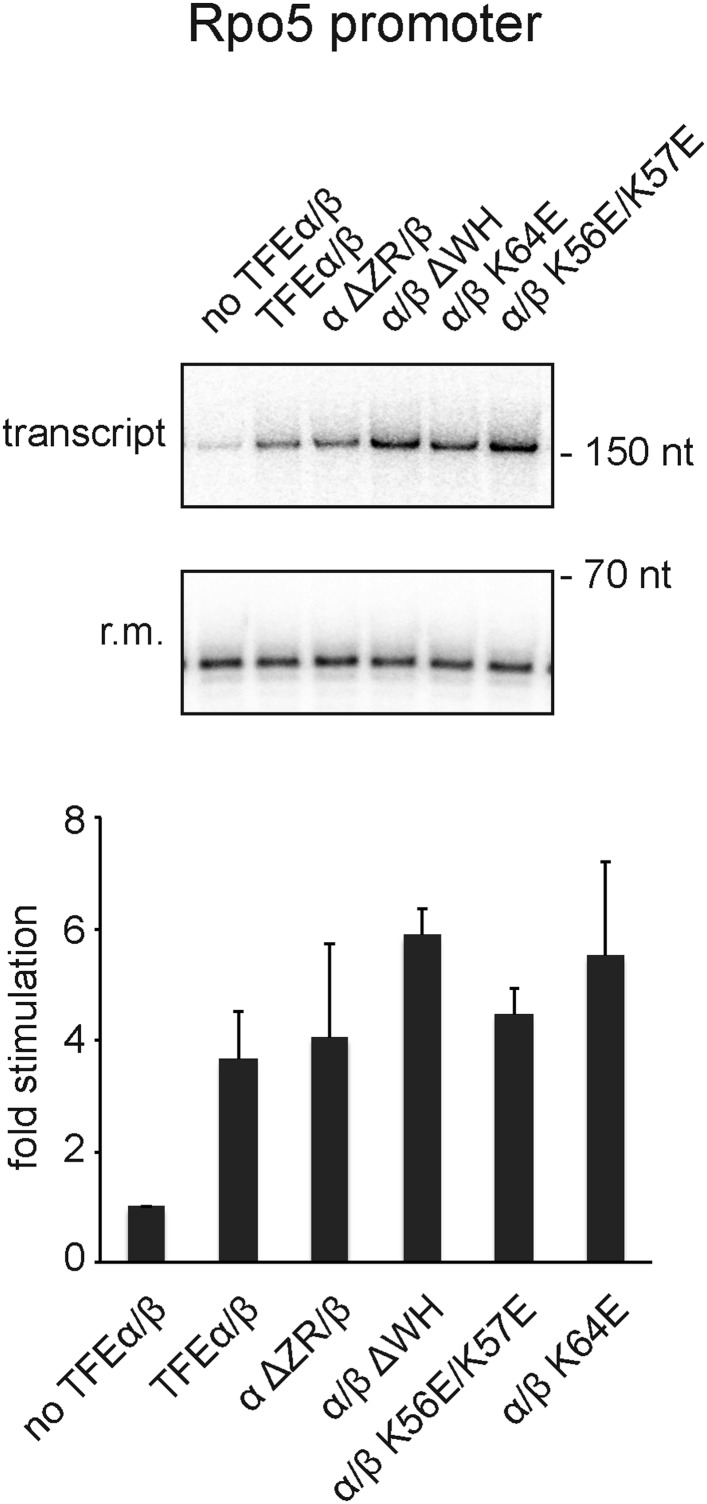
Effect of TFEα/β mutant variants on productive transcription on the Rpo5 promoter.Transcription assays and quantification were carried out as described above with 3 µM TFEα/β or variant. The mean of three technical replicates is shown. Error bars depict 1× standard deviation.